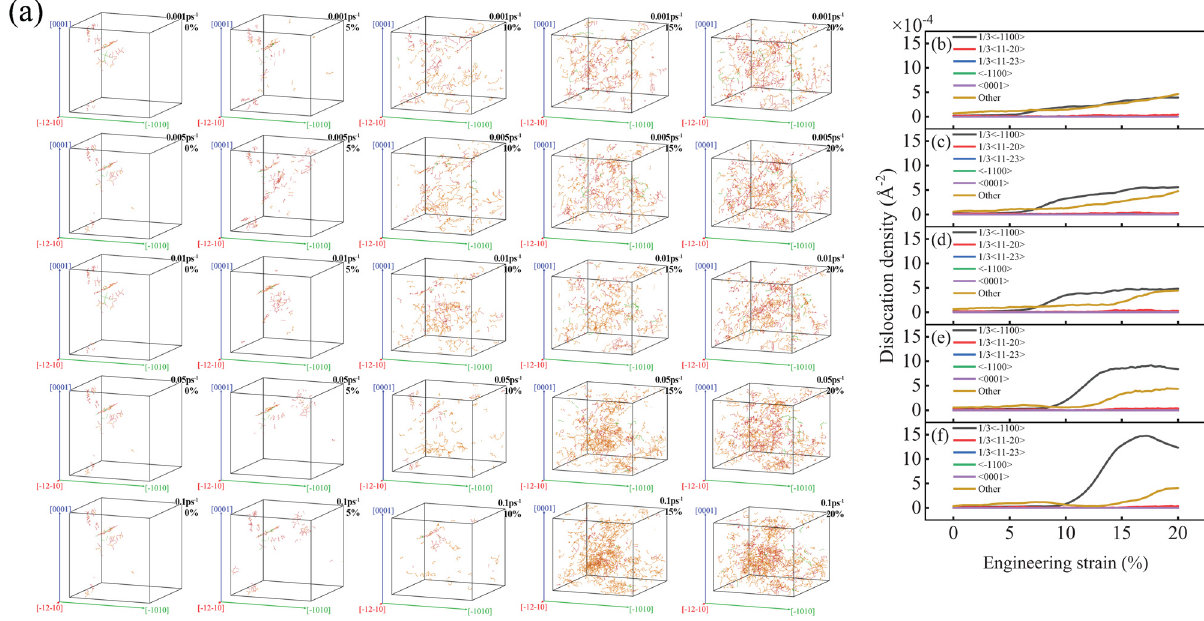
Figure 22: Dislocation evolution: ( a ) dislocation line diagram and ( b ) – ( f ) dislocation density